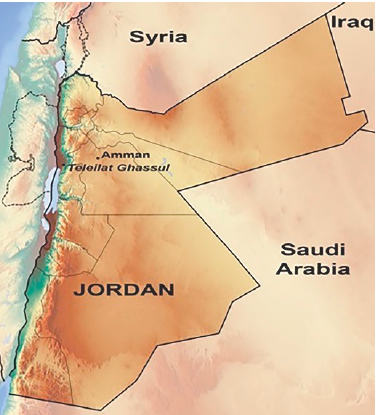
Figure 1. Map of Jordan showing Teleilat Ghassul (created by author).